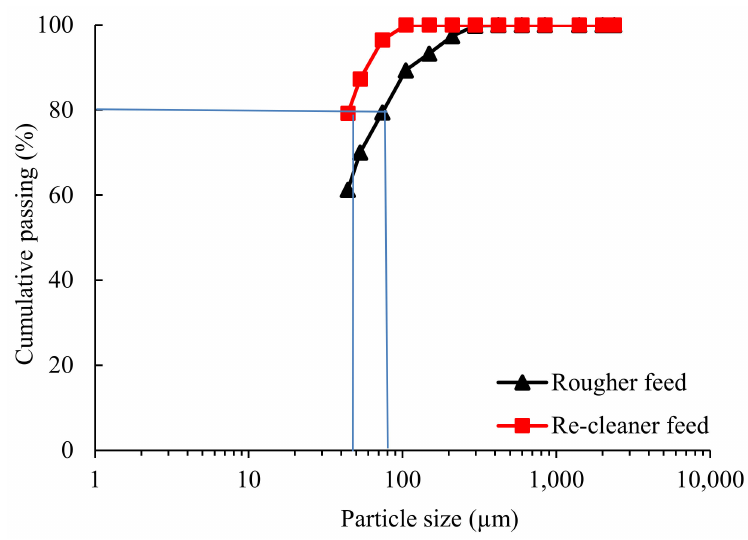
Figure 1. Particle size distribution of the samples fed to the laboratory flotation cells.